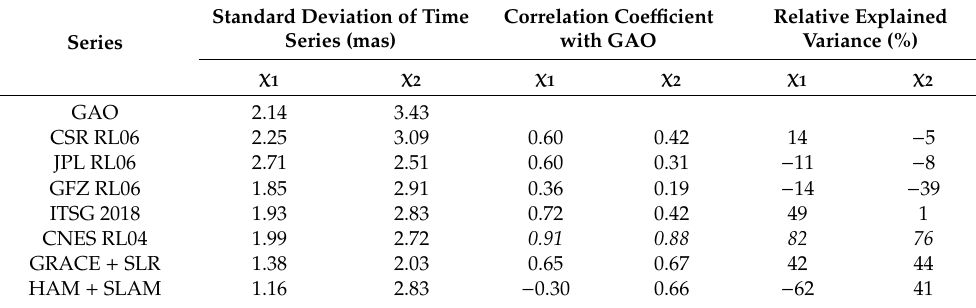
Table 7. Standard deviation of GSMAM, GAO, GRACE + SLR, and HAM + SLAM time series, correlation coe ffi cients with GAO, and percentage of variance in GAO explained by GSMAM, GRACE + SLR and HAM + SLAM. Oscillations with periods 450–1000 days are considered. The critical value of the correlation coe ffi cient for 20 independent points and a confidence level of 0.95 is equal to 0.38. A standard error of a di ff erence between two correlation coe ffi cients for 20 independent points is equal to 0.34. The highest values of correlations and relative explained variances are italicized.